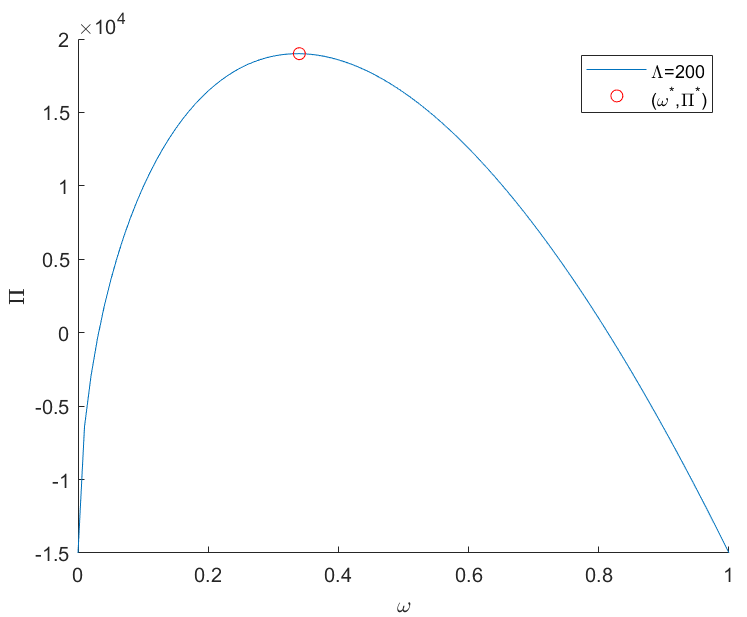
Figure 6. Advertisers’ cost allocation decisions and benefits. Note: U 0 = 100, t 1 = 100, t 2 = 20, l = 600, β = 0.1, C = 15000, k = 1, ρ = 1, τ = 1 .